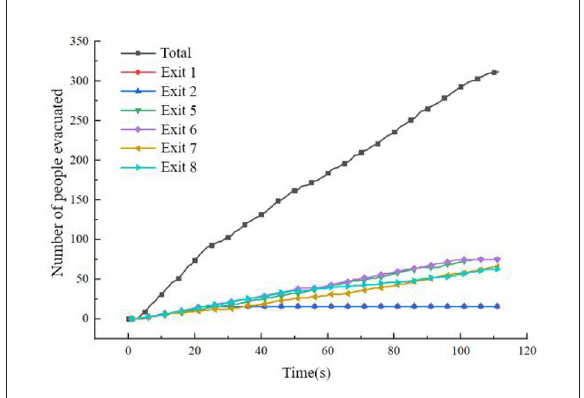
FIGURE23 Statistics of evacuated people after adding guidance.